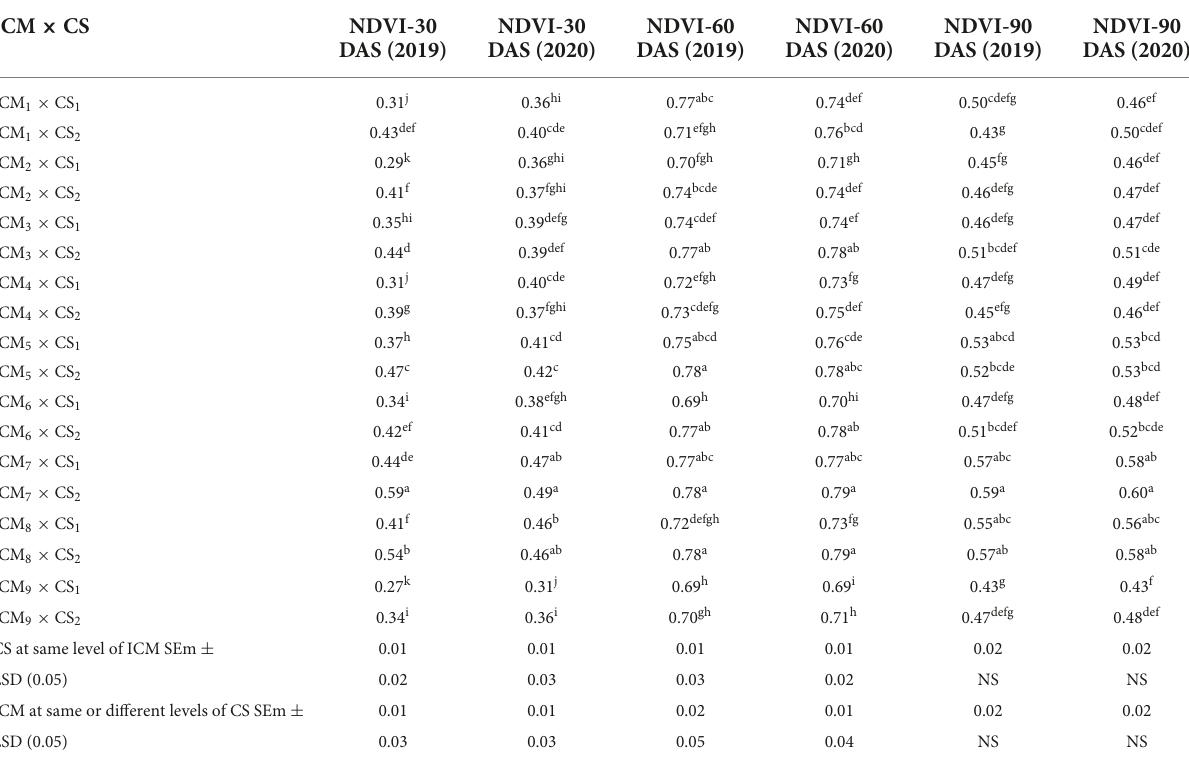
TABLE 5 Integrated crop management (ICM) modules × cropping system (CS) interaction effects on NDVI values of maize at 30-days interval under maize a . ICM × CS